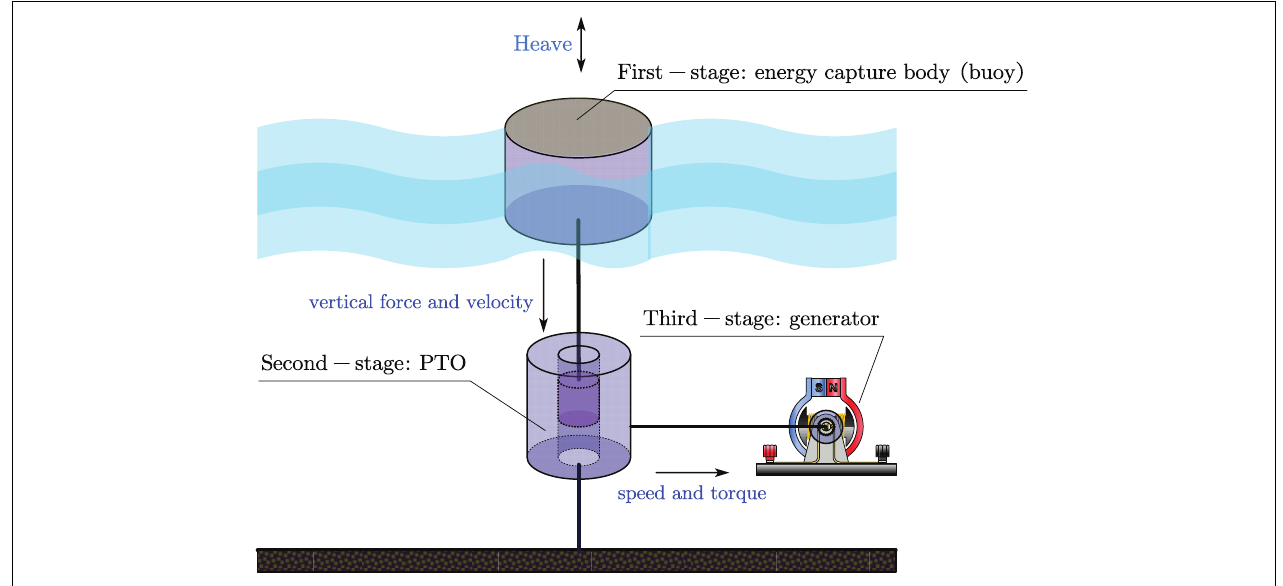
FIGURE 6 | Single-degree-of-freedom heave oscillating buoy